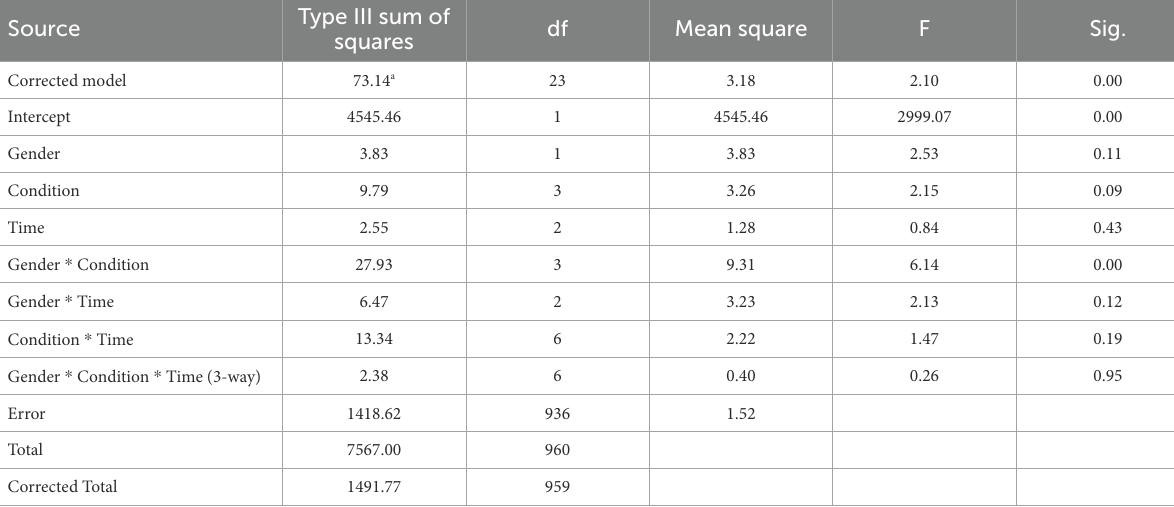
TABLE 7 Be a Scientist – MLE analysis with time, condition, and